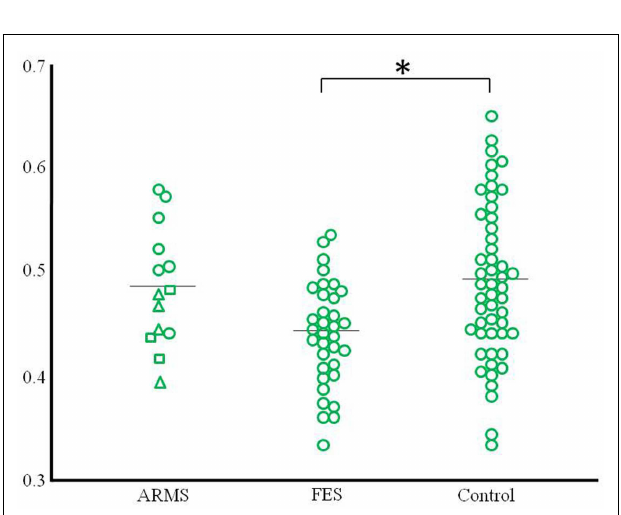
FIGURE 1 | Group difference of the gray matter between the schizophrenia patients and the healthy controls. The cluster in which the schizophrenia patients show gray matter reduction is located in the left anterior cingulate gyrus.